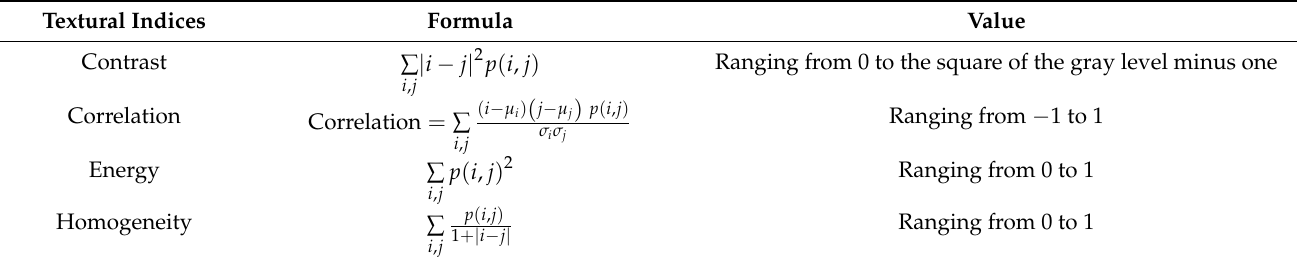
Table 3. Definition of textural indices used in this